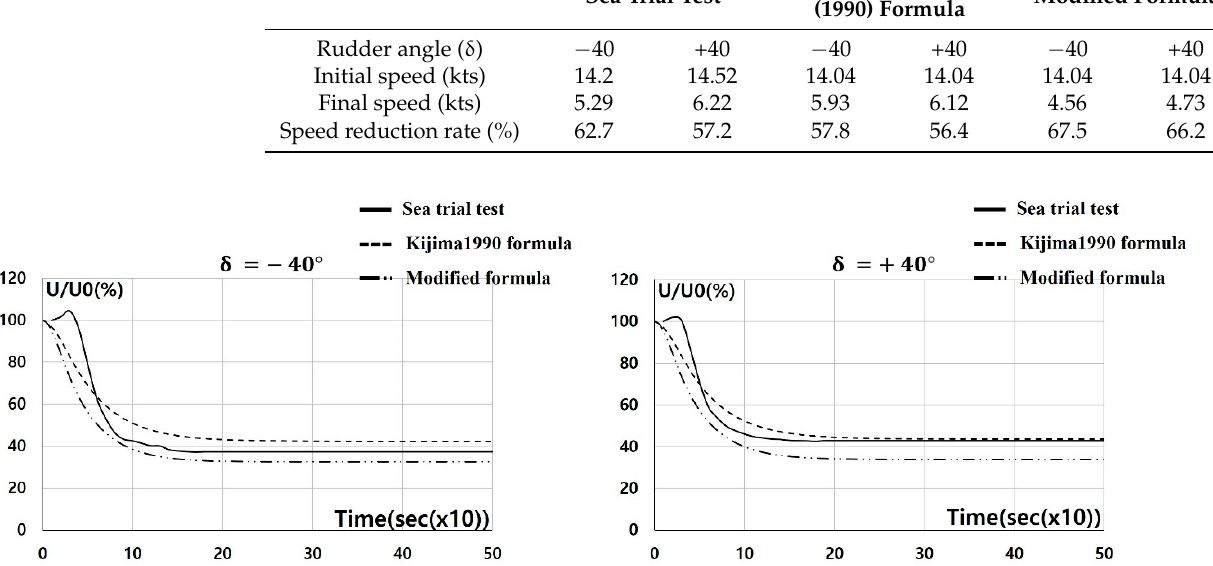
Table 9. Comparison of the 10/10 zigzag test results for the target trawler. Sea Trial Test